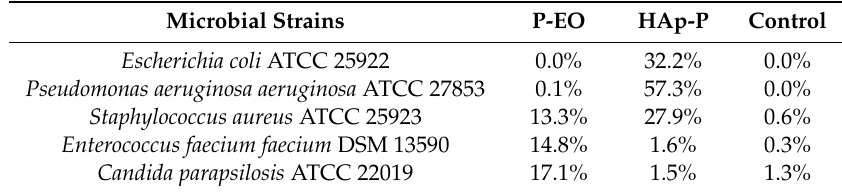
Table 3. The percentage of depolarized bacterial cells treated with the selected plant EO and Hap and coated with plant EOs at MIC